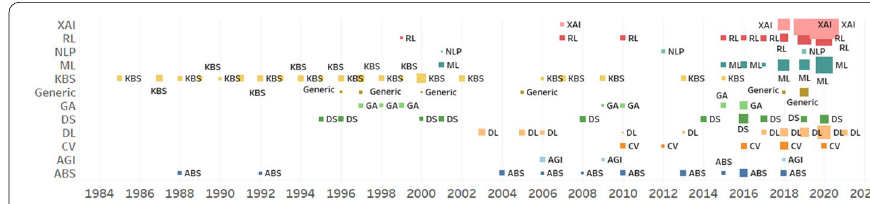
Fig. 1 A history of AI assurance by year and subarea